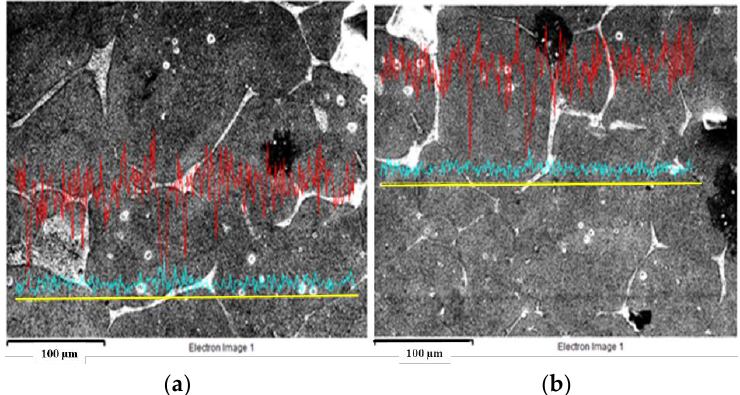
Figure 5. EDS analysis for the ZnAl22 alloy (thermal treated condition) in the biphasic zone (S + L) for two ( a – b ) different areas.